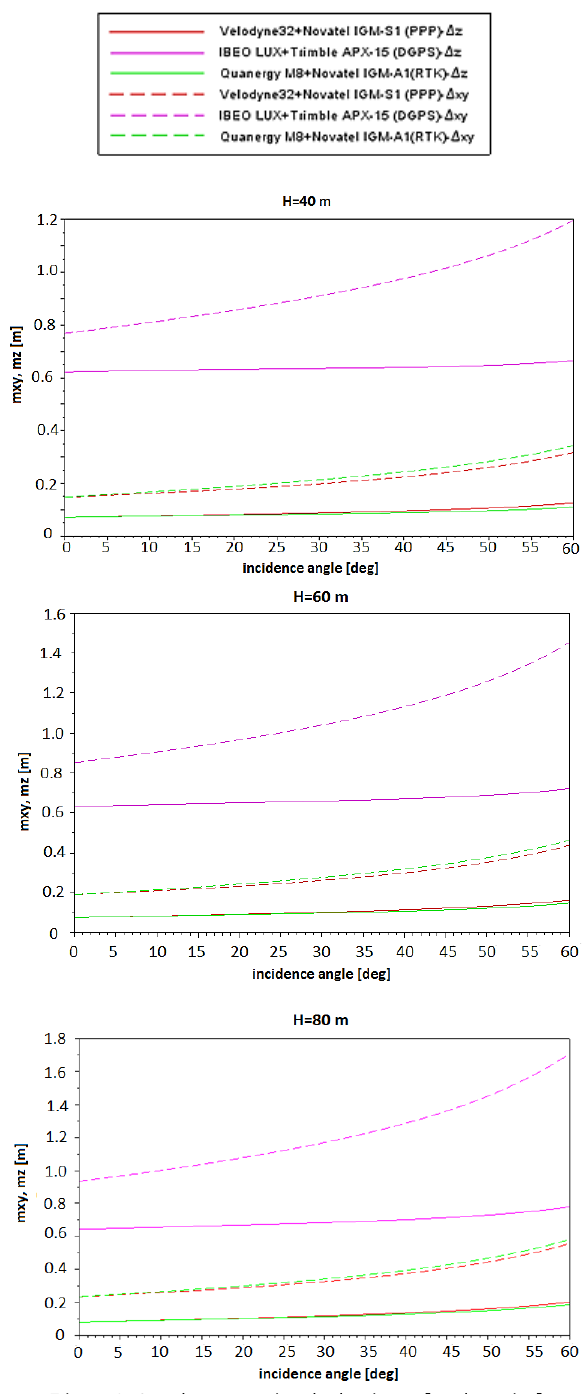
Figure 2. Graphs presenting the horizontal and vertical measurement accuracies for chosen combinations of LiDAR and navigational